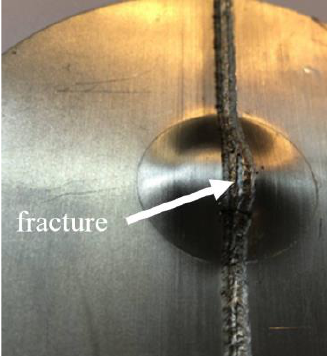
Figure 10. Example of fracture in the weld seam of an Erichsen cupping test